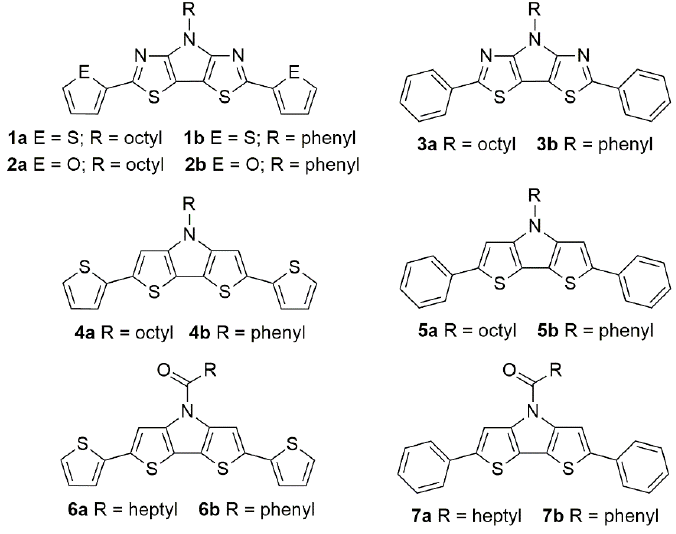
Figure 3. Diaryl-capped PBTz and DTP oligomers.